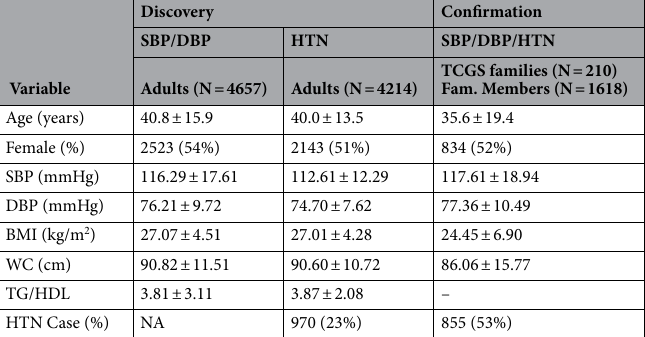
Table 1. Descriptive characteristics of phenotypes and covariates in GWAS and confirmation datasets. Mean ± standard deviation, NA not applicable, Fam. Members family